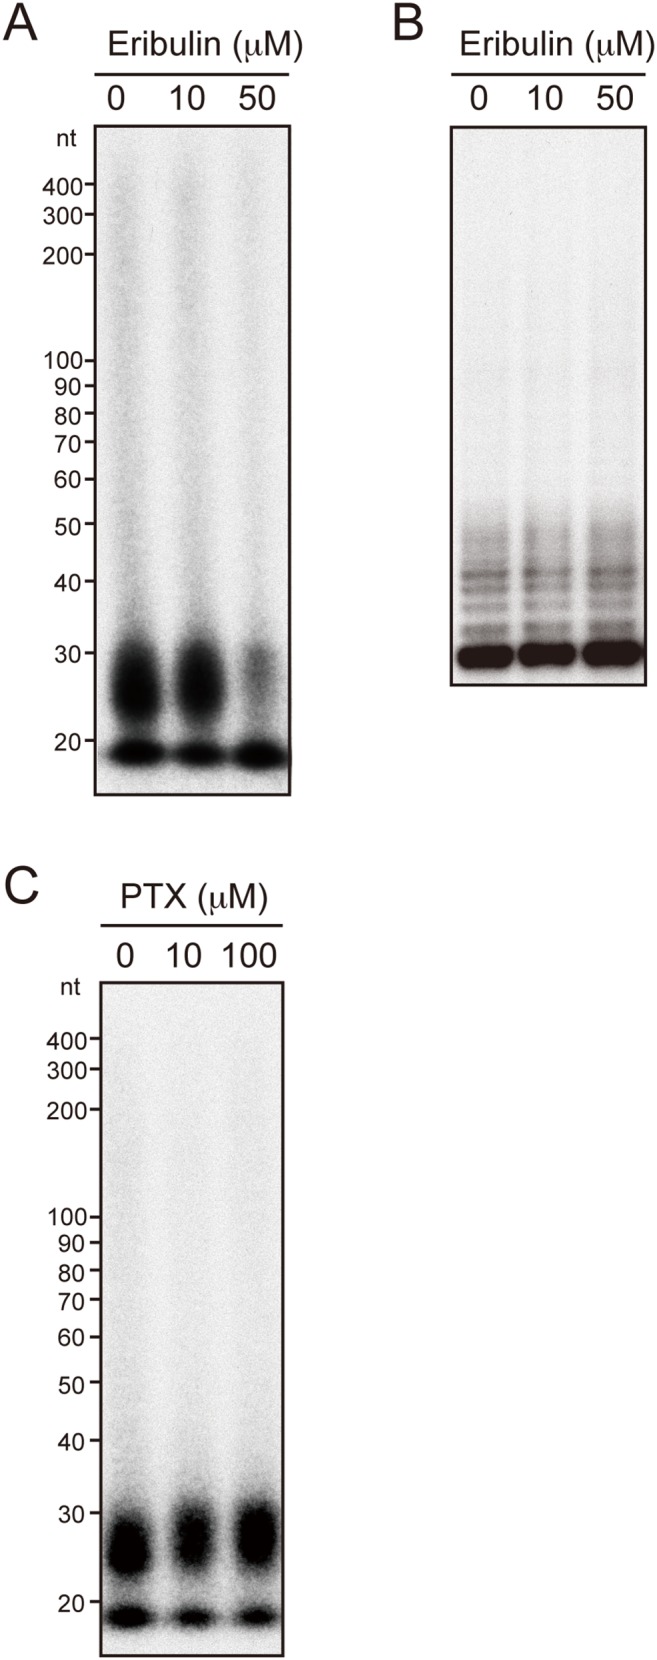
Eribulin inhibits RdRP activity but not telomerase activity of hTERT.(A) RdRP activity of hTERT immune complexes prepared from HeLa cells arrested in the mitotic phase was assayed without or with 10 and 50 µM eribulin. (B) Telomerase activity in HeLa cell extracts was assayed without or with 10 and 50 µM eribulin. (C) RdRP activity of hTERT immune complexes was assayed without or with 10 and 100 µM paclitaxel (PTX).